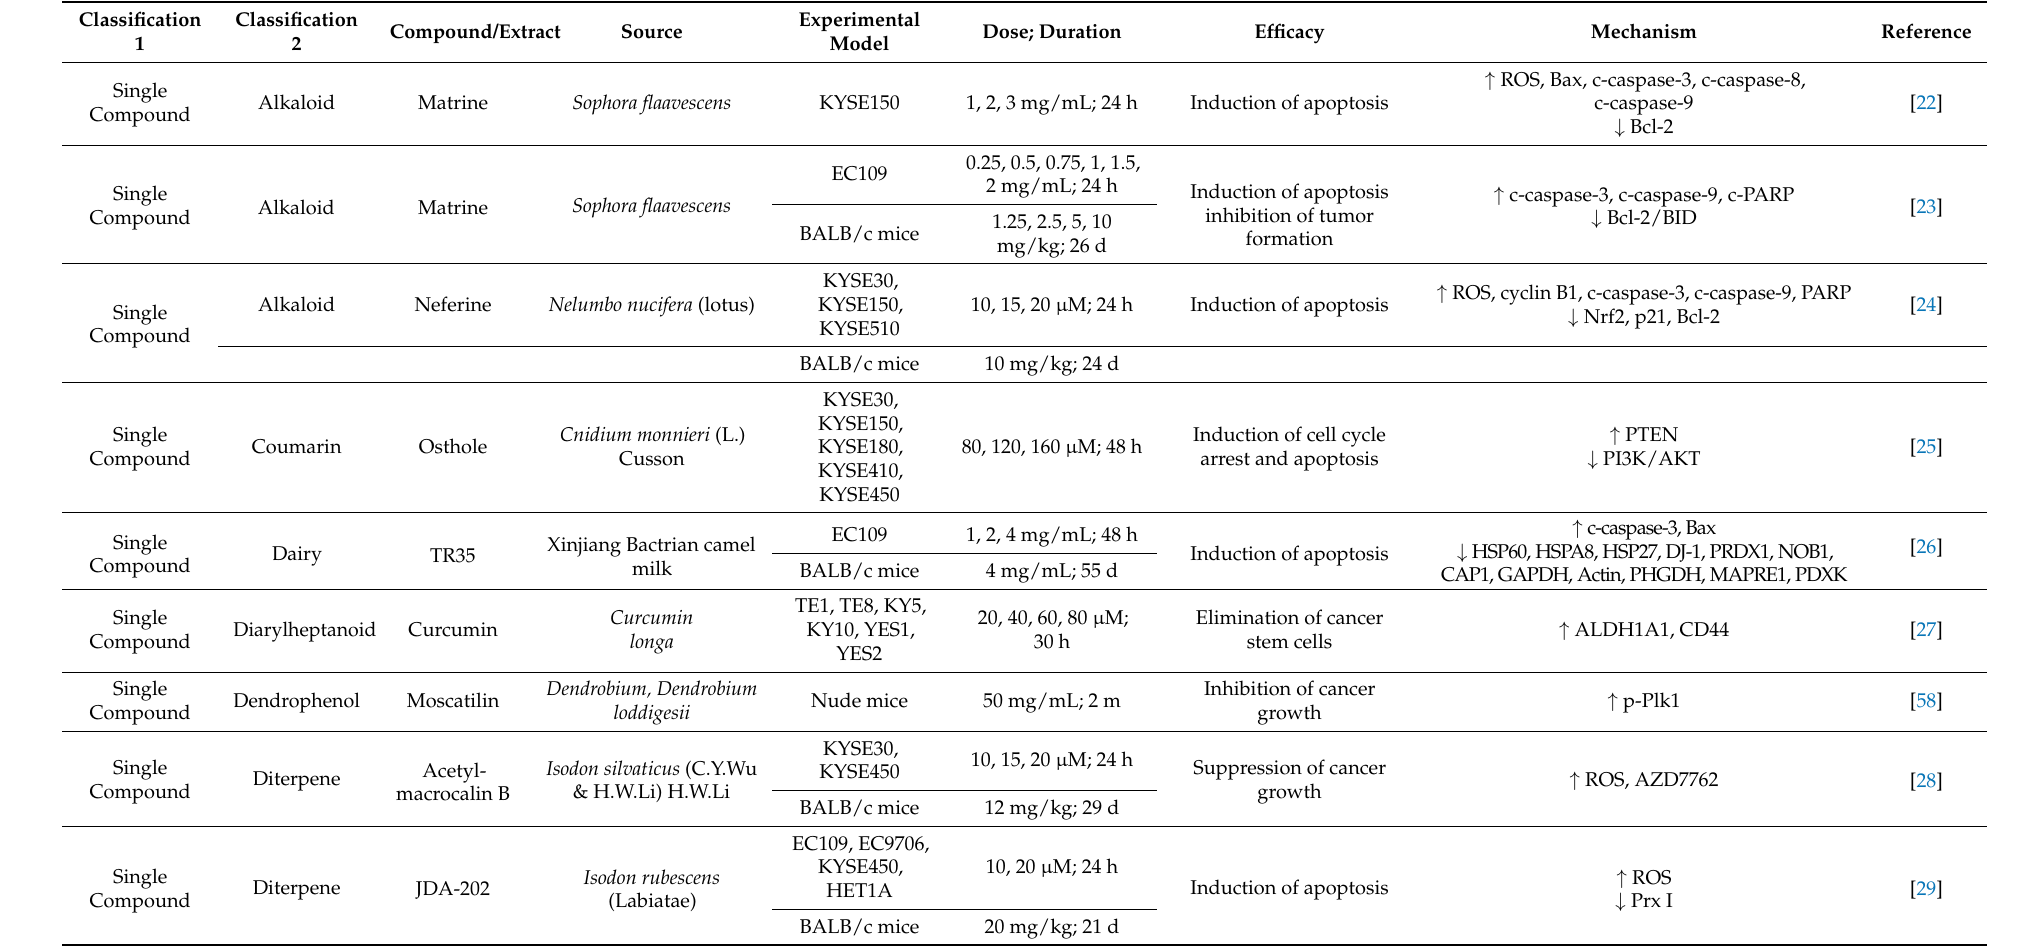
Table 1. Apoptosis-inducing natural